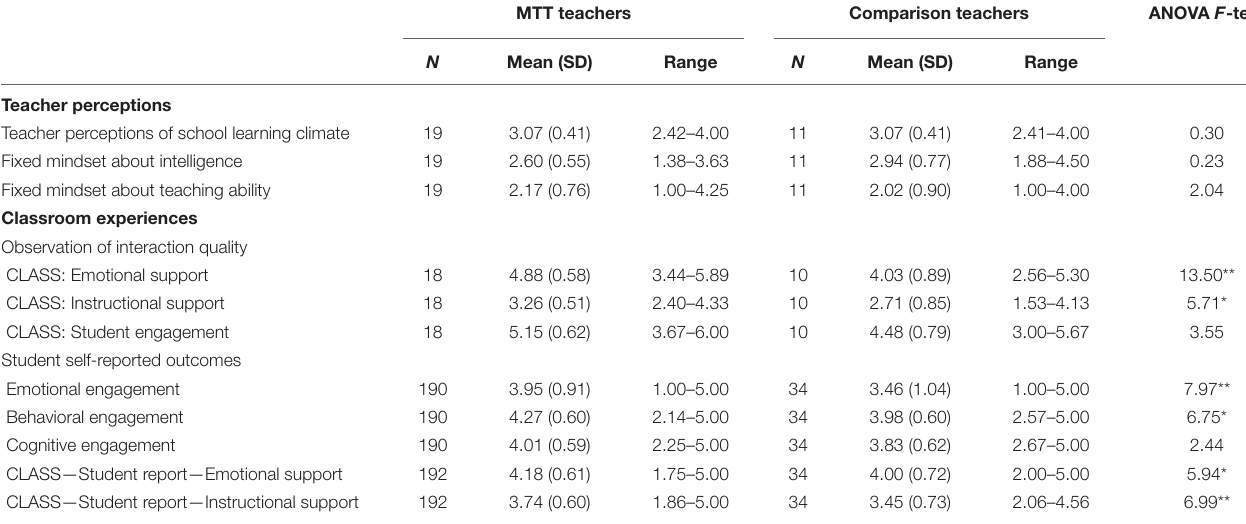
TABLE 3 | Descriptive statistics of study